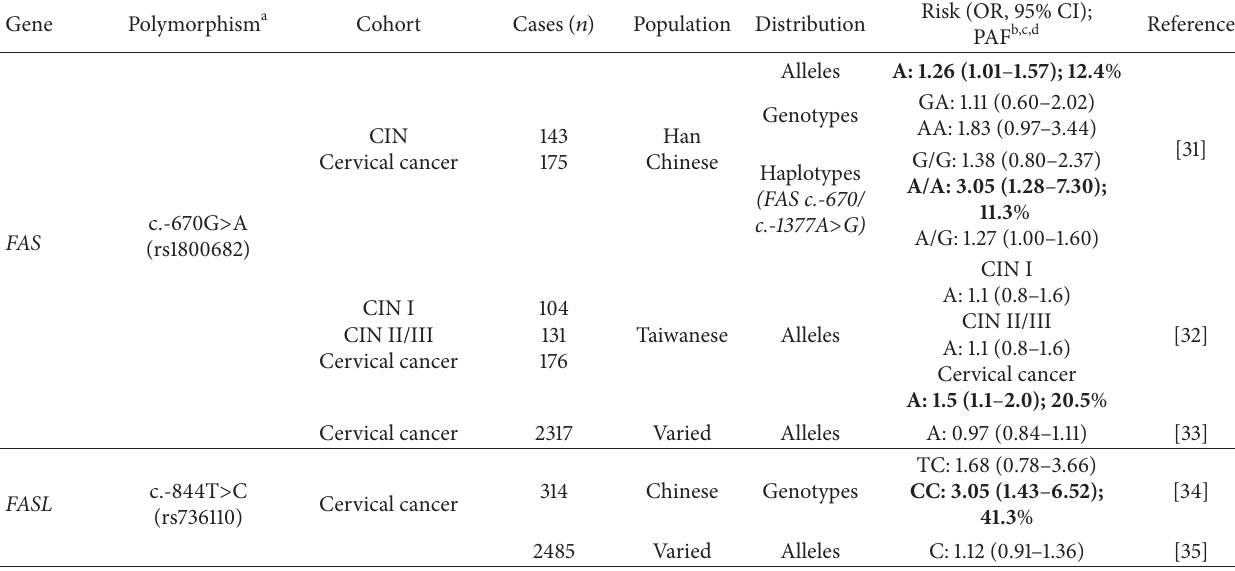
Table 4: Overview of polymorphism in FAS and FASL genes encoding receptors and association with cervical neoplasia risk. Gene Polymorphism